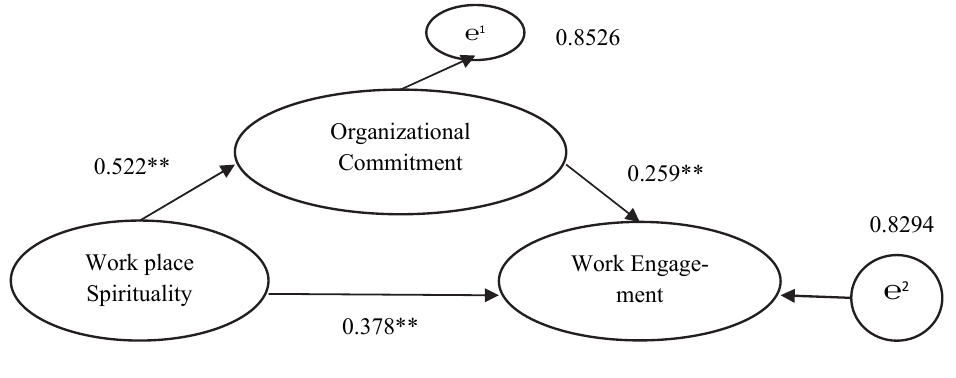
Fig. 3. The Relationship between Workplace Spirituality (WS), Organizational Commitment (OC), and Work Engagement (WE) The mediated variable could be calculated as follow: e1 score was 0.8526, e2 score was 0.8294, P3 score was 0.274, Sp2 score was 0.056, P2 score was 0.529, Sp3 score was 0.066 and, the Sp2p3 score was 0.03831 . In purpose to test